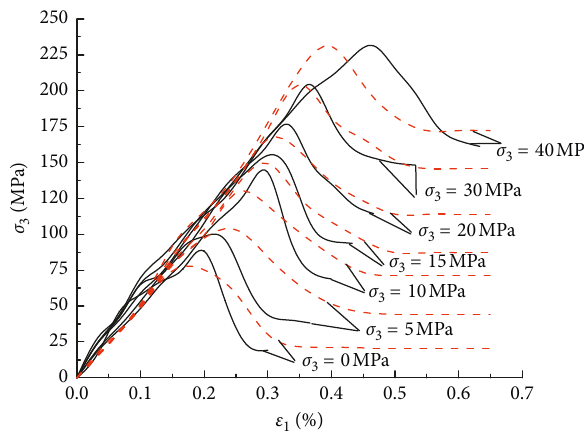
Figure 11: Strain-softening behaviour and numerical reproduction (rock